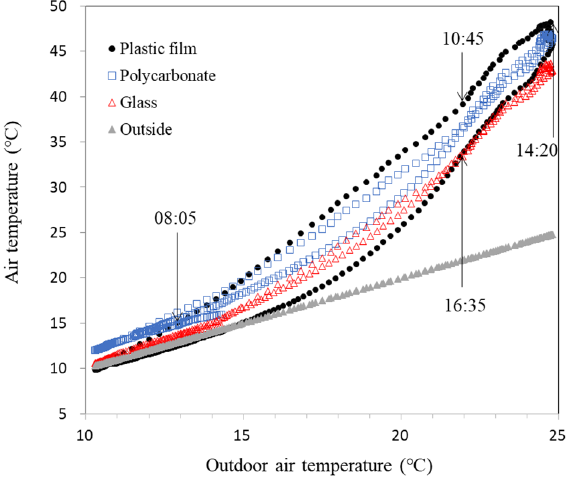
Figure 6. Comparison of indoor and outdoor air temperatures as a function of outdoor air temperature in greenhouses covered with different covering materials (12 − 13, 19 − 20, and 26 − 27 October 2019).